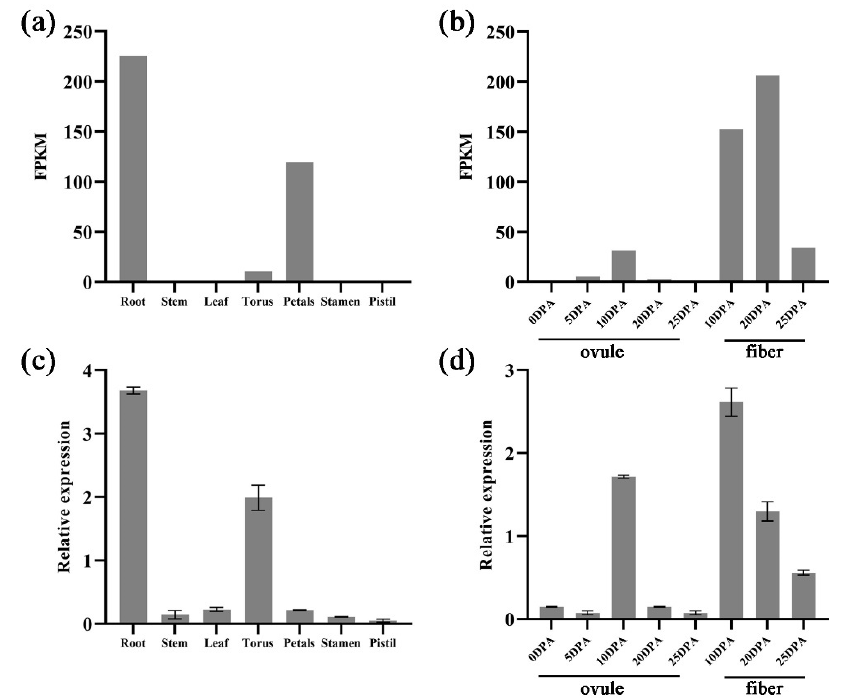
Figure 3. Expression patterns of GhNAC82 in different tissues and development periods. ( a , b ) The expression patterns of GhNAC82 in different tissues were plotted according to FPKM (Fragments Per Kilobase per Million mapped reads) values; ( c , d ) The expression patterns of GhNAC82 in various tissues and different stages of ovule and fiber development were plotted according to the results by quantitative real-time PCR.